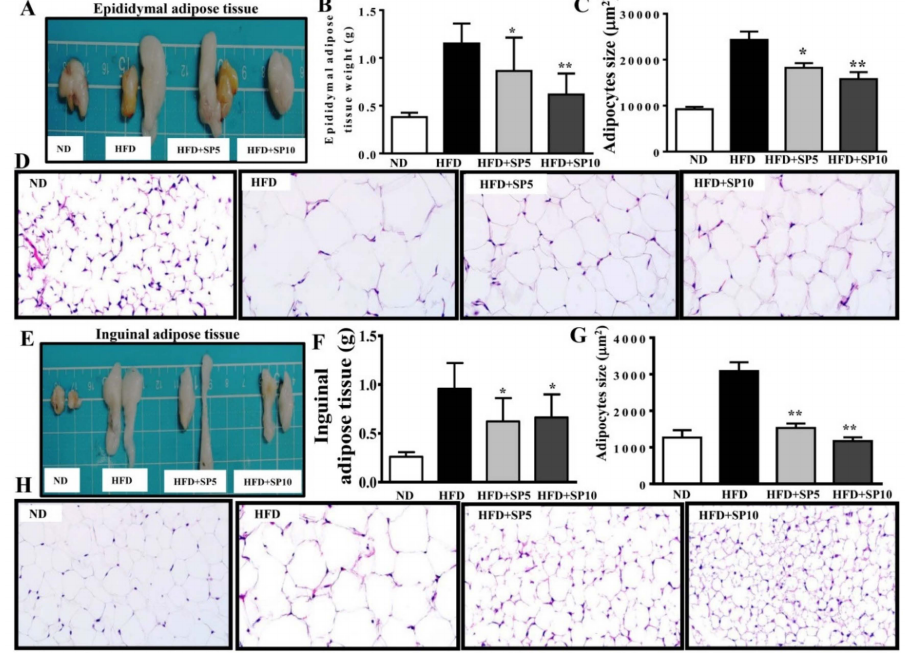
Figure 6. Spilanthol (SP) reduces HFD-induced visceral adipocyte tissue weight and adipocyte size. ( A ) Representative image of epididymal adipose tissue. ( B ) Epididymal adipose tissue weight. ( C ) Epididymal adipocyte size. ( D ) Histological sections of epididymal adipose tissues from mice (400 × ). ( E ) Representative image of inguinal adipose tissue. ( F ) Inguinal adipose tissue weight. ( G ) Inguinal adipocyte size. ( H ) Histological sections of inguinal adipose tissue (400 × ). C57BL / 6 mice were fed a normal diet (ND) or high-fat diet (HFD) with or without a low dose of SP (5 mg spilanthol / kg BW; SP5) or high dose of SP (10 mg spilanthol / kg BW; SP10) for eight weeks. The data are presented as means ± SD, n = 8; * p < 0.05, ** p < 0.01 compared to HFD-fed mice